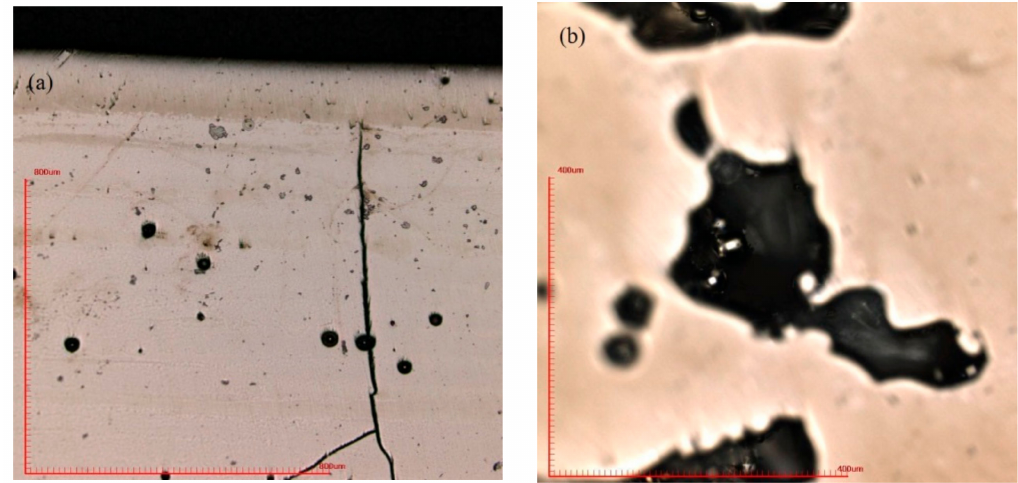
Figure 6. ( a ) Cracks and macro-pores revealed in the SLM matrix (P = 200 W, t = 60 µ s); ( b ) partially melted powder in the macro-pore (P = 120 W, t = 60 µ